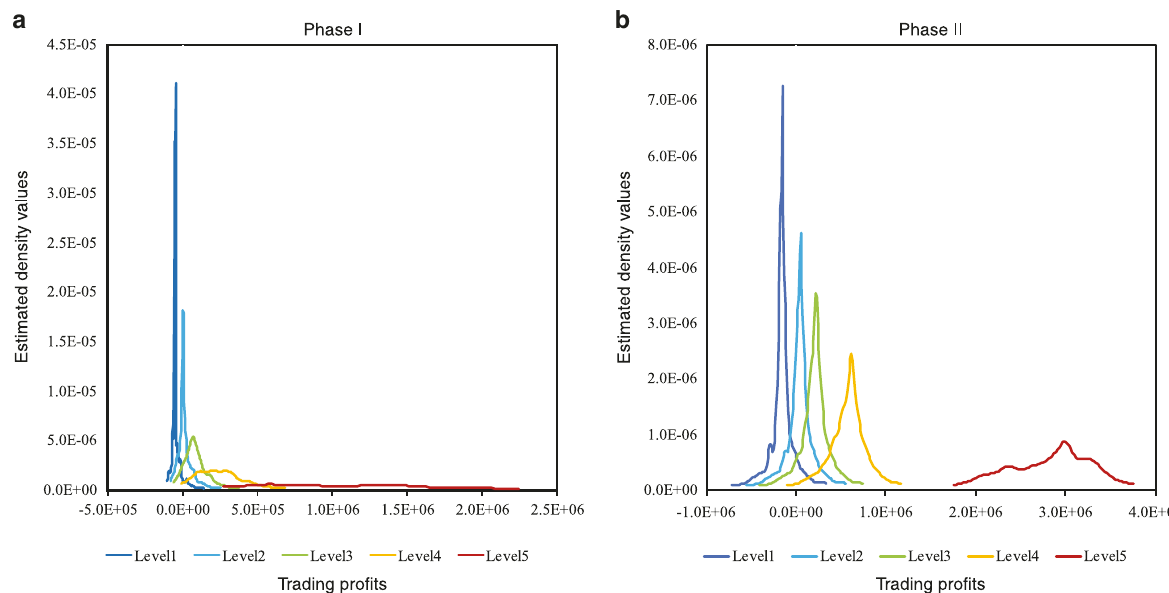
Fig. 1 Comparison of the pro fi t distributions in different quantiles based on the fi rm-level trading data. Five distributions (line Level 1 to Level 5) are presented with trading pro fi ts of the 0.10, 0.30, 0.50, 0.70, and 0.90 quantiles. The densities of the distributions are calculated by the estimated conditional quantile. a , b The pro fi t distributions of Phase I and II of the EU ETS, respectively.